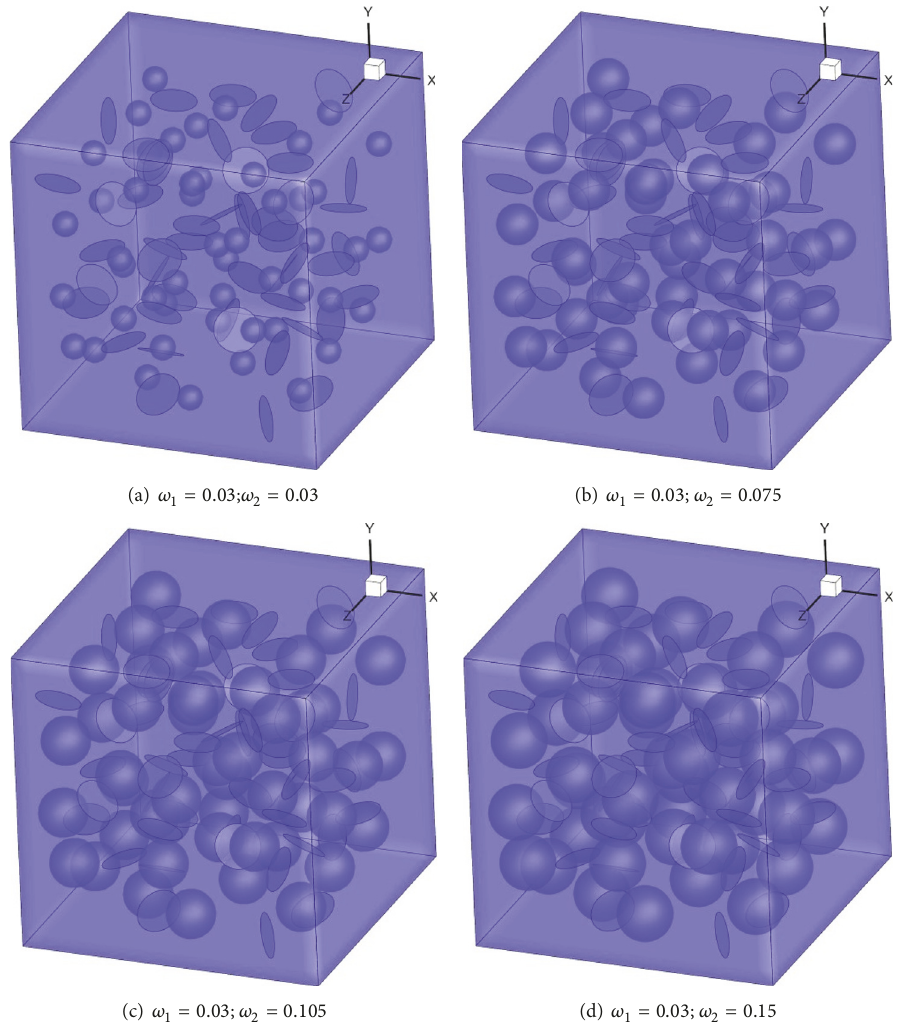
Figure 13: A model with a fixed microcrack density and growing